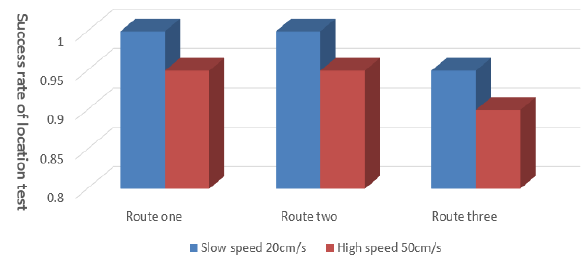
Figure 13.Location test success rate about three